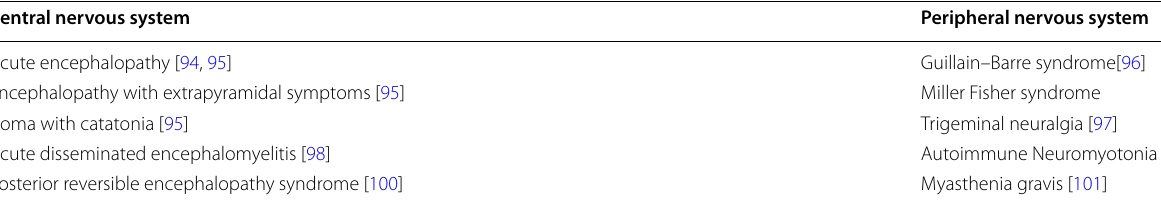
Table 2 Neurological manifestations following wasp stings Central nervous system